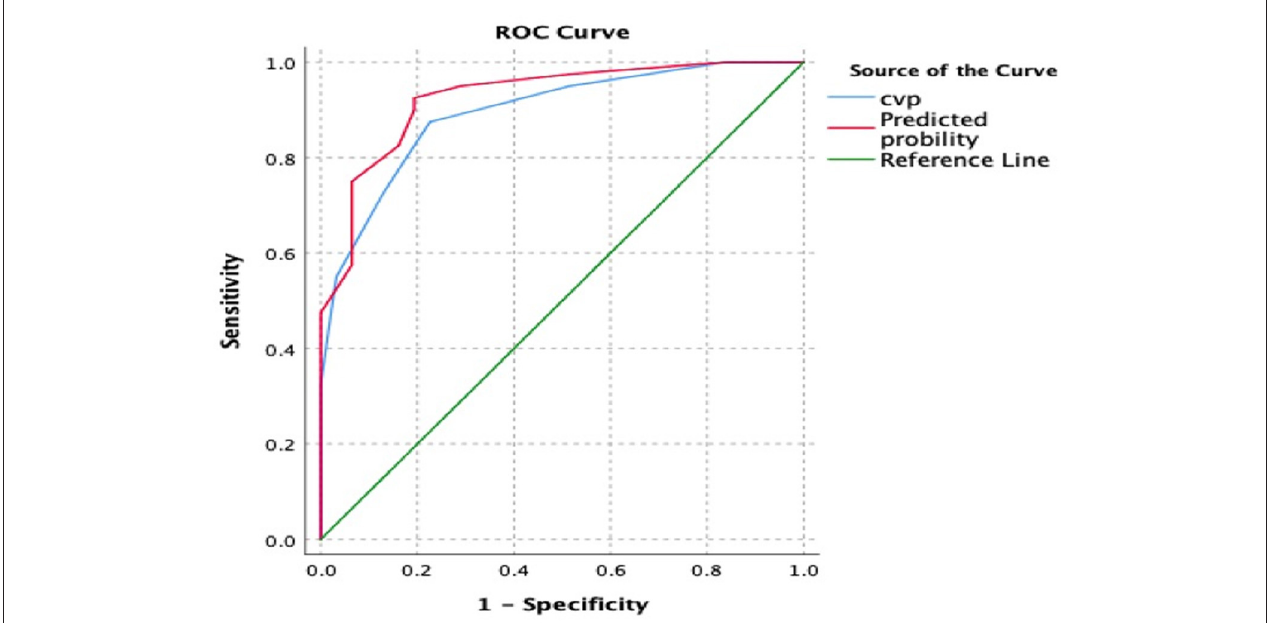
FIGURE 5 | The receiver operating characteristic (ROC) curves and the area under the ROC curve (AUC) for prediction of VTI increase after negative fluid balance. The “red model” included CVP and RV D /LV D ratio, while the “blue model” only included CVP. The AUC was 0.926 and 0.894, respectively. VTI, velocity time integral; CVP, central venous pressure; RV D /LV D ratio, right to left ventricular diastolic dimensions